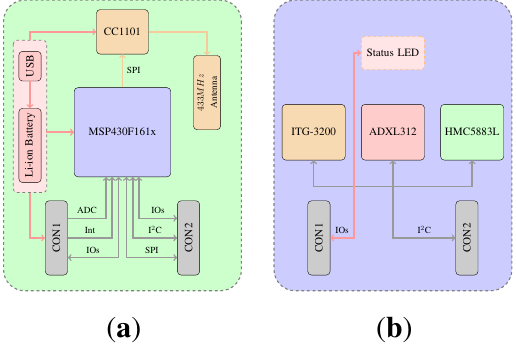
Figure 2. Integrated Posture and Activity Network by Medit Aachen (IPANEMA) design and components. ( a ) IPANEMA main board design; ( b ) IPANEMA 9DOF node